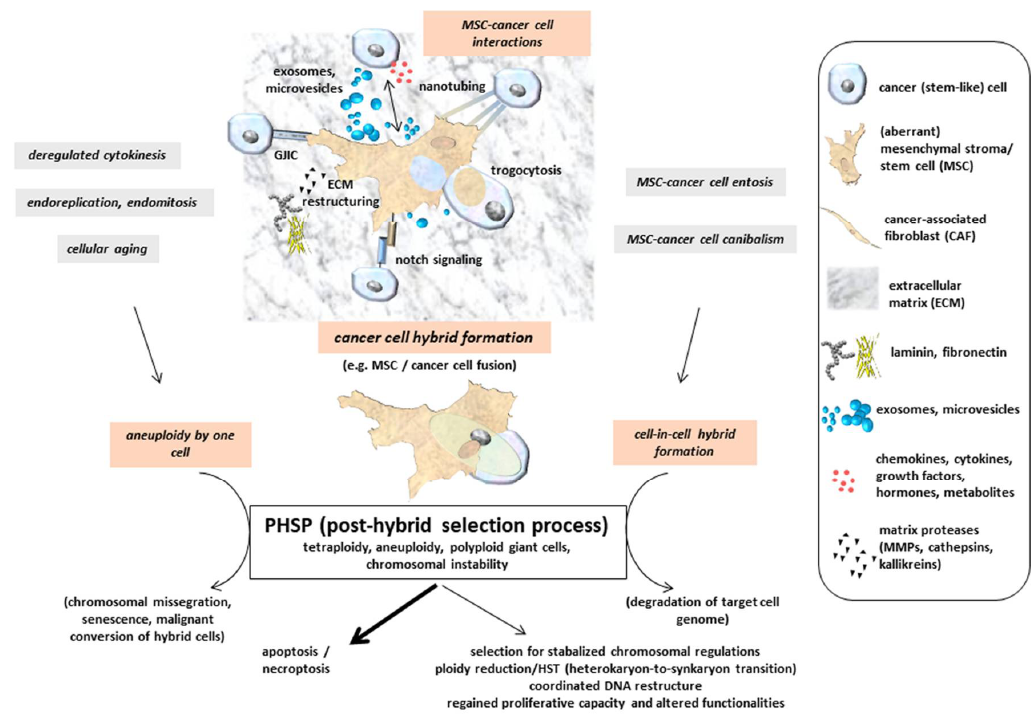
Figure 2. Indirect interactions between MSC and cancer cells are performed by a mutual exchange of a plethora of soluble factors, including microvesicles and exosomes, which may also provide therapeutic vehicles [75,76]. Moreover, direct cell–cell interactions include gap junctional intercellular communication (GIJC), signaling via notch receptor and ligand, and exchange of cytoplasmatic compounds and small organelles (e.g., mitochondria) via nanotubes or trogocytosis. Tight assembly of the two plasma membranes from MSC and cancer cells provide a fusion permissive prerequisite for subsequent hybrid cell formation. Further mechanisms add to the generation of hybrid cells, which undergo a post-hybrid selection process (PHSP) to cope with aneuploidy and chromosomal instabilities. (adapted from [77]).